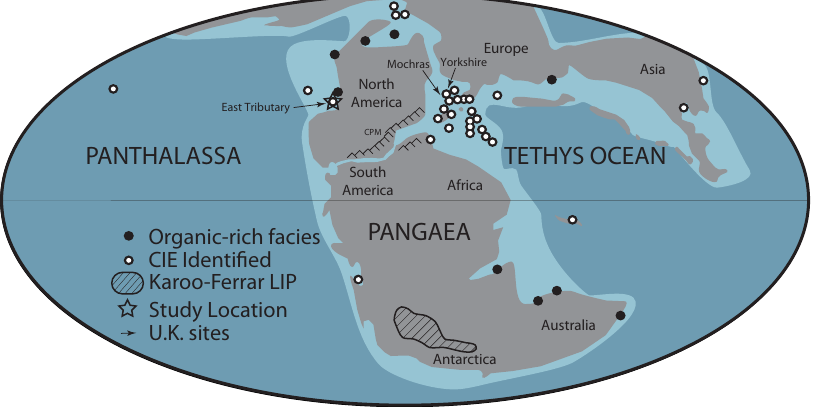
Figure 1. Global palaeogeography of the Early Toarcian (modified from ref. 71). Star represents this study’s location. Arrows point to the UK study locations 20, 23 , which are geographically close to one another. Hatched outline in southern Pangaea (present-day southern Africa and Antarctica) represents location and known extent of Karoo-Ferrar Large Igneous Province. Dark grey represents landmasses, light blue represents shallow seas, and dark blue represents open oceans. CPM = Central Pangaean Mountains. See ref. 15 for a list of locations that document the T-OAE